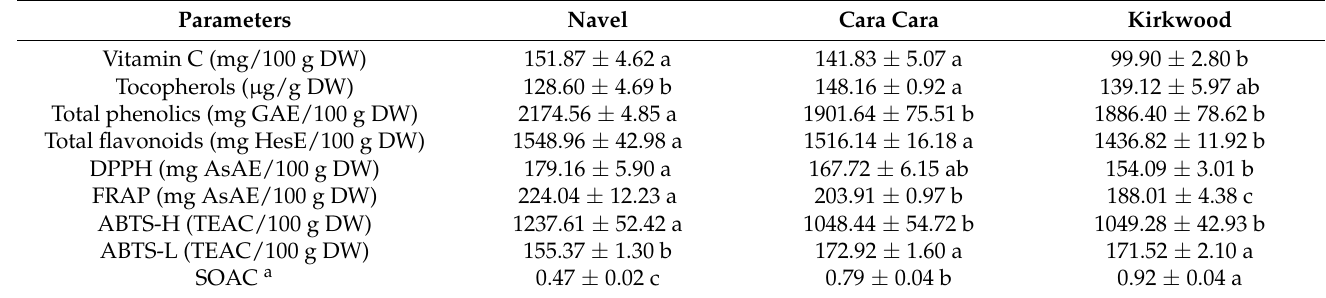
Table 6. Content of vitamin C, tocopherols, total phenolics, total flavonoids, and antioxidant capacity (DPPH, FRAP, ABTS-H, ABTS-L, and SOAC) of Navel, Cara Cara, and Kirkwood orange